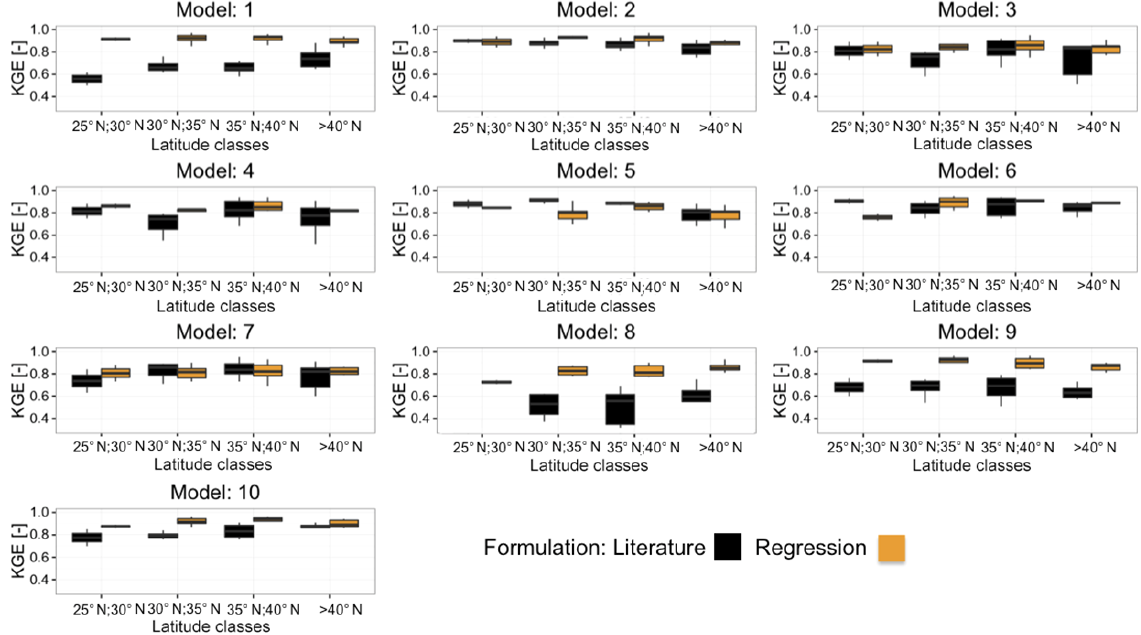
Figure 8. Comparison between model performances obtained with regression and classic parameters: the KGE values shown are those above 0.3 and results are grouped by latitude